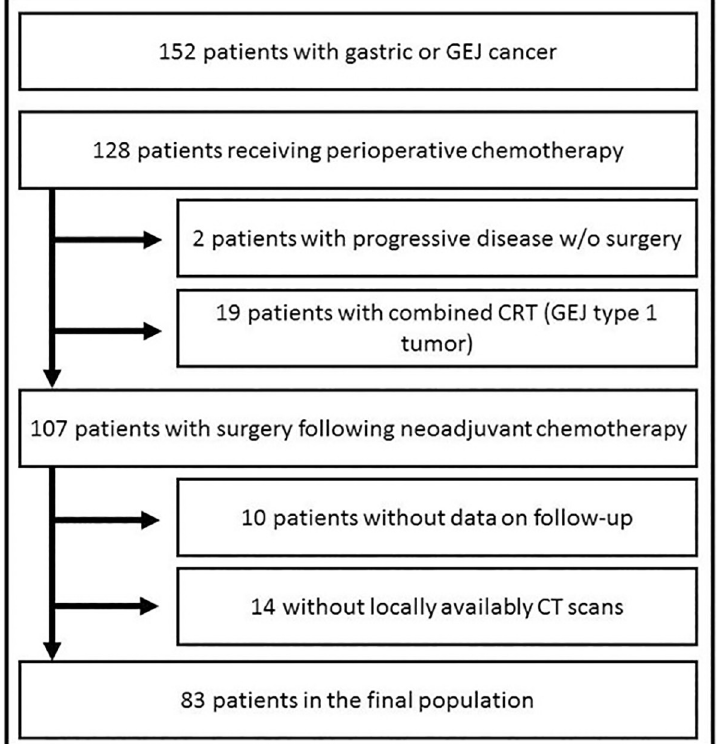
Fig 1. Flow diagram. 60 patients (72.3%) were male and 23 (27.7%) female. 45 patients (54.2%) had GEJ type 1–3 and 38 (45.8%) gastric tumors, respectively. Details on demographic data are given in Table 1 .